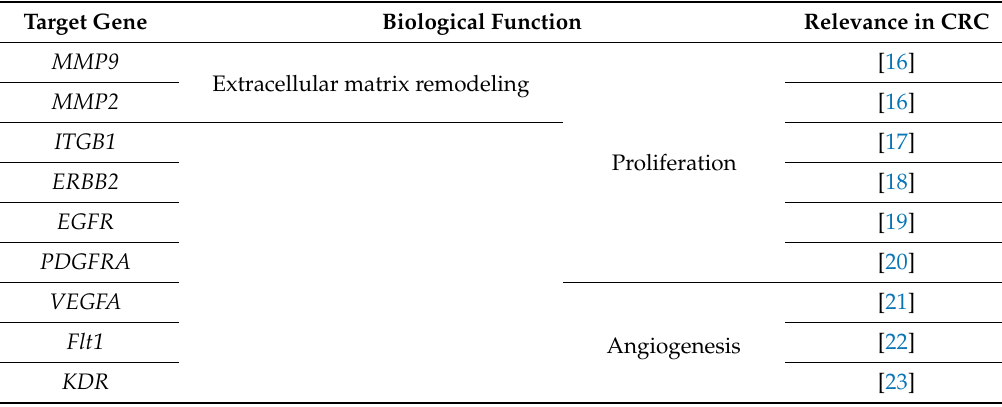
Table 1. Summary of the target genes included in the molecular